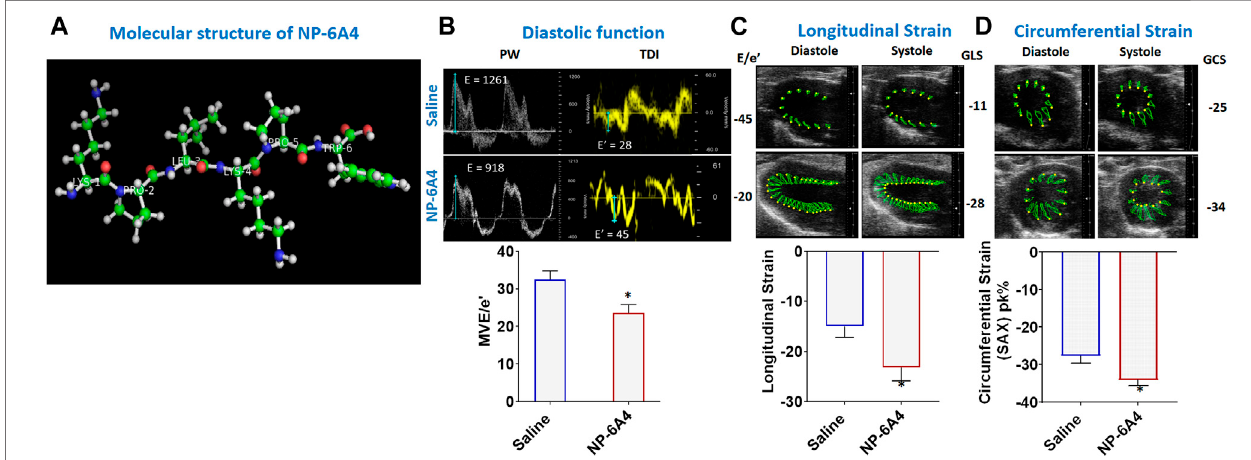
FIGURE 1 | NP-6A4 attenuates cardiac diastolic dysfunctionand improvesmyocardial longitudinalandcircumferential strain inZO rats with untreated diabetesand obesity. (A) Structure of NP-6A4, a patented six amino acid peptide agonist of the AT2R with the orphan drug designation for pediatric cardiomyopathy from the FDA. (B) Representative Pulse Wave Doppler and Tissue Doppler spectra from a saline- (top panels) or NP-64A-treated (bottom panels) ZO rat. Note the lower E/e ’ ratio in theNP-64A4treatedratcomparedtotheuntreatedrat,indicatinglowerLV fi llingpressurewithNP-64Atreatment. (C) Representativeimagestakenintheparasternal longaxisviewfromasaline-treatedrat (toppanes) takenatend-diastoleandend-systoleindicateendocardiallongitudinaldeformationduringthecardiaccyclecompared tothosefromanNP-64A4-treatedrat (bottompanels) . (D) Representativeimagestakenintheshortaxisviewfromasaline-treatedrat (toppanels) takenatenddiastole and end systole indicate endocardial circumferential deformation during the cardiac cycle compared to those from an NP-64A4-treated rat (bottom panels) .